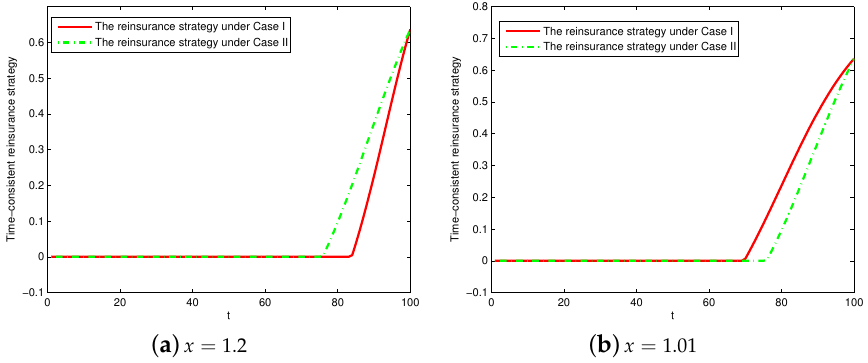
Figure 8. Nash equilibrium reinsurance strategy under the variance value premium principle ( α =